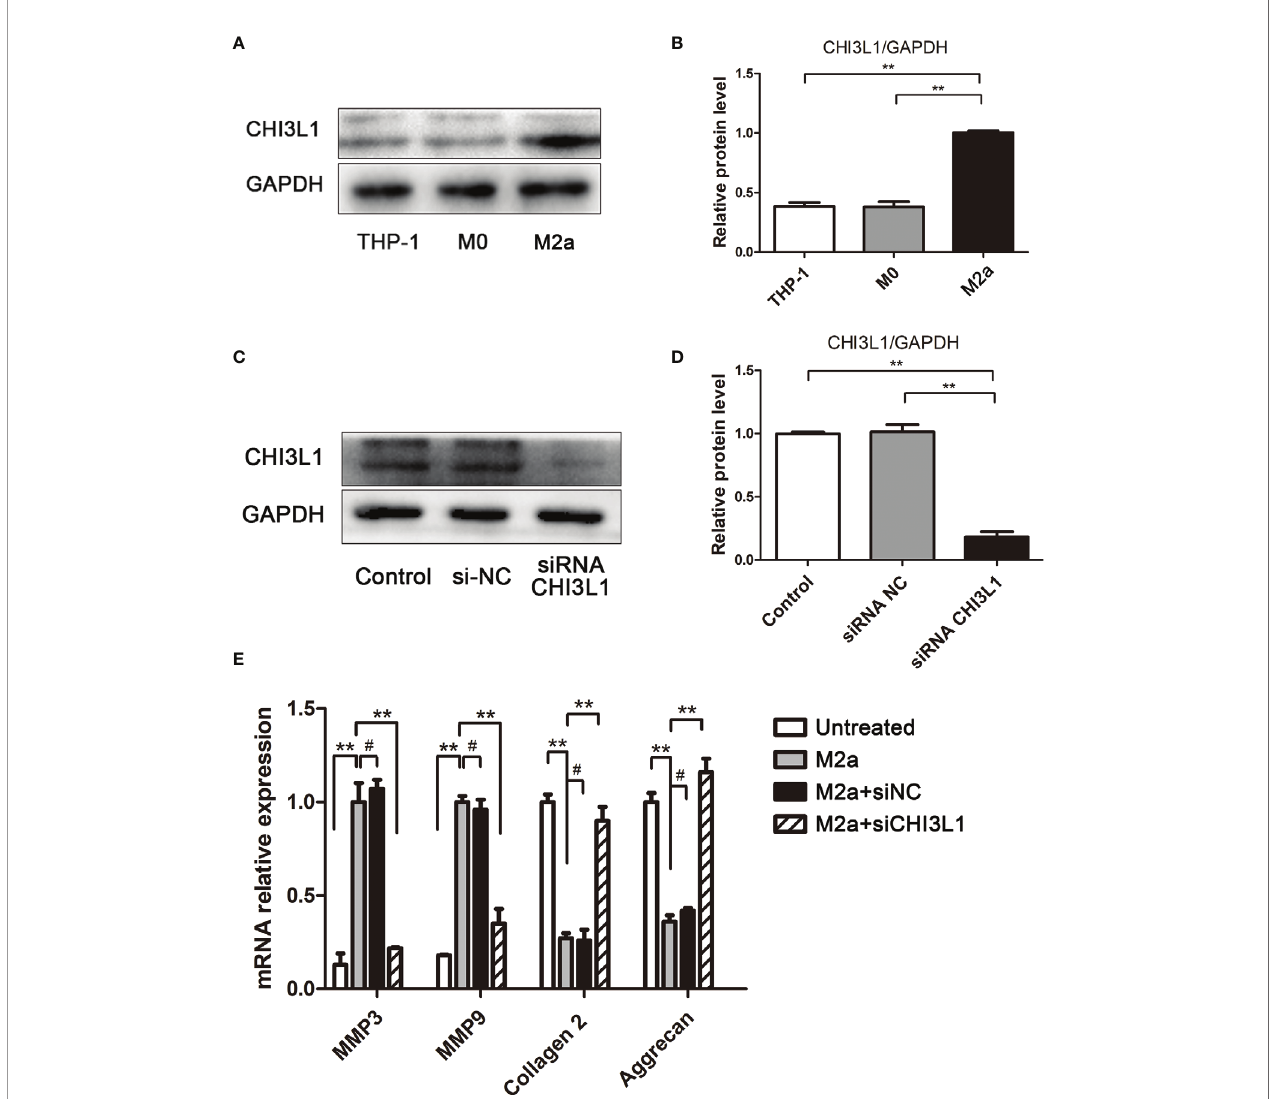
FIGURE 3 | CHI3L1 mediated M2a macrophage-induced ECM degradation. (A) Expression of CHI3L1 in M2a macrophages. M0 and M2a macrophages were differentiated from THP-1 monocytes. The protein levels of CHI3L1 in THP-1, M0 and M2a macrophages were detected by western blotting. (B) Quanti fi cation of CHI3L1 protein levels in western blots. (C) siRNA silencing of CHI3L1 in M2a macrophages. After transfection with NC siRNA or CHI3L1 siRNA, the knockdown of CHI3L1 in M2a macrophages was con fi rmed by western blotting. (D) Quanti fi cation of CHI3L1 protein levels in western blots. (E) Effects of CHI3L1 silencing in M2a macrophages on ECM degradation in NP cells. After co-culture with CHI3L1-silenced M2a macrophages, the expression levels of MMP3, MMP9, collagen II and aggrecan in NP cells were analyzed by qRT-PCR. Experiments were repeated three times in triplicate. The dates were analyzed by One-way analysis of variance (ANOVA). Signi fi cant differences between groups are shown as **p < 0.01. #, no statistical